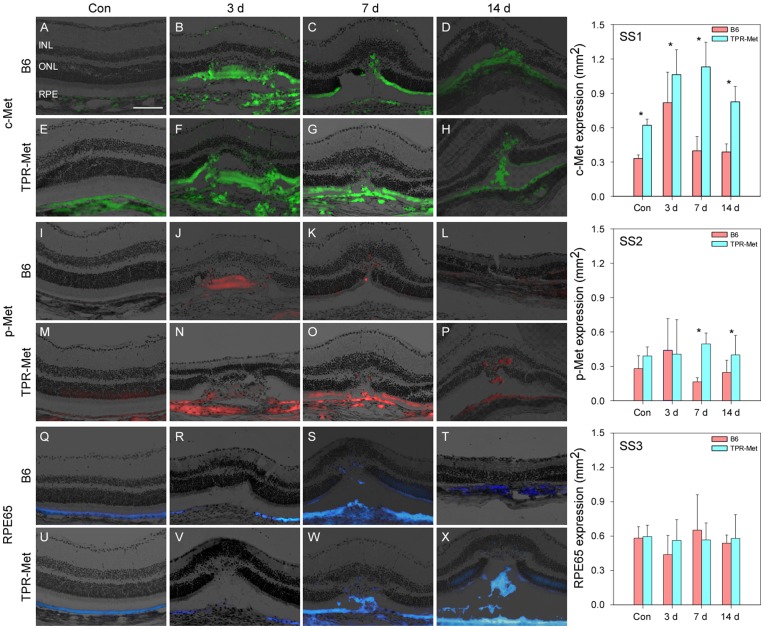
Dynamic changes in expression of c-Met, p-Met and RPE65 in the retina of B6 and TPR-Met mice after laser injury.After sham laser injury, very trace c-Met expression was detected in the control retina (A). c-Met expression was increased up to day 3 (B). On day 7 and 14, c-Met expression (C – D) decreased but remained higher than control (A). Similarly, in TPR-Met mice, c-Met expression significantly increased after laser injury (F) although obvious expression was found in sham-treated eyes (control; E). c-Met expression decreased from day 7 to day 14. On day 7, migrated c-Met positive cells were observed in the outer retina (C – D, G – H). On day 14, the disrupted RPE layer was reformed as a monolayer (D, H). Expression of (phosphorylated) p-Met was similar between B6 and TPR-Met mice (I – P). p-Met was not detected in control retina of B6 mice (I), but p-Met was detected as early as 3–6 hr after the laser injury. Expression of p-Met in the laser-treated areas obviously diminished (J) on day 3 and was almost undetected from day 7 to day 14 (K – L). Several p-met positive migrating cells were observed after day 7 (K – L). p-Met expression was found in the control retina of TPR-Met mice (M) and dramatically increased on day 1 after the laser injury (N – P). Some migrated cells were detected from day 7 to day 14 (O – P). Expression of p-Met in TPR-Met mice after laser treatment was higher than in B6 mice (I – P). Expression of RPE65 in B6 mice on day 7 after laser treatment was significantly higher than other conditions (S) but there was no difference between control, day 3 and day 14 (Q – R, T). In TPR-Met mice, RPE65 expression slightly decreased after laser injury on day 1 compared to control (U – V), but significantly increased from day 7 to day 14 (W – X). The RPE layer in B6 and TPR-Met mice showed disorganized morphology after laser burns up to day 3 but started to reform on day 7 and completely reformed on day 14. The expression of c-Met in B6 and TPR-Met mice rapidly increased after the laser injury (SS1). However, p-Met did not show obvious changes after the laser burns (SS2). Expression of RPE65 in laser-treated B6 and TPR-Met mice was quite similar between B6 and TPR-Met mice at different time point (SS3). The scale bar for all images: 100 µm. * P<0.05, independent samples t-test.